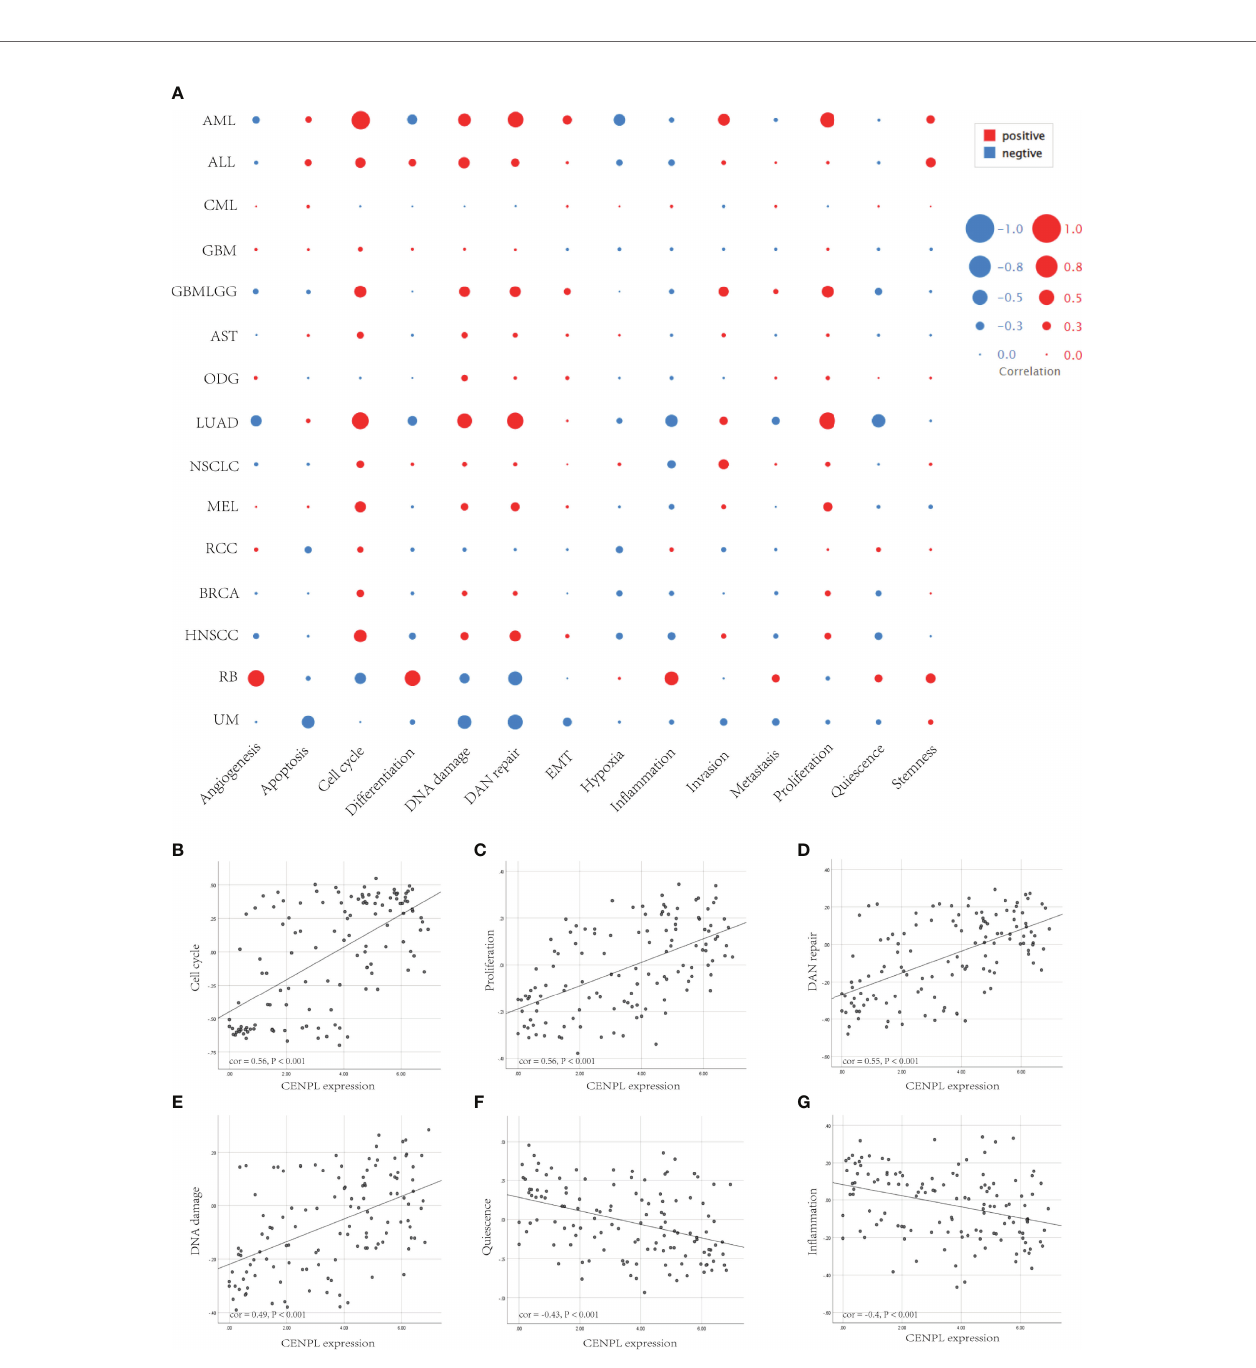
FIGURE 8 | The correlation between CENPL expression and 14 cancer functional states using single-cell sequence data from the CancerSEA database. (A) The correlation between CENPL expression and 14 cancer functional states in pan-cancer. (B – E) The expression of CENPL is positively correlated to the cell cycle, proliferation, DNA repair, and DNA damage of LUAD. (F, G) The expression of CENPL is negatively correlated to the quiescence and in fl ammation of